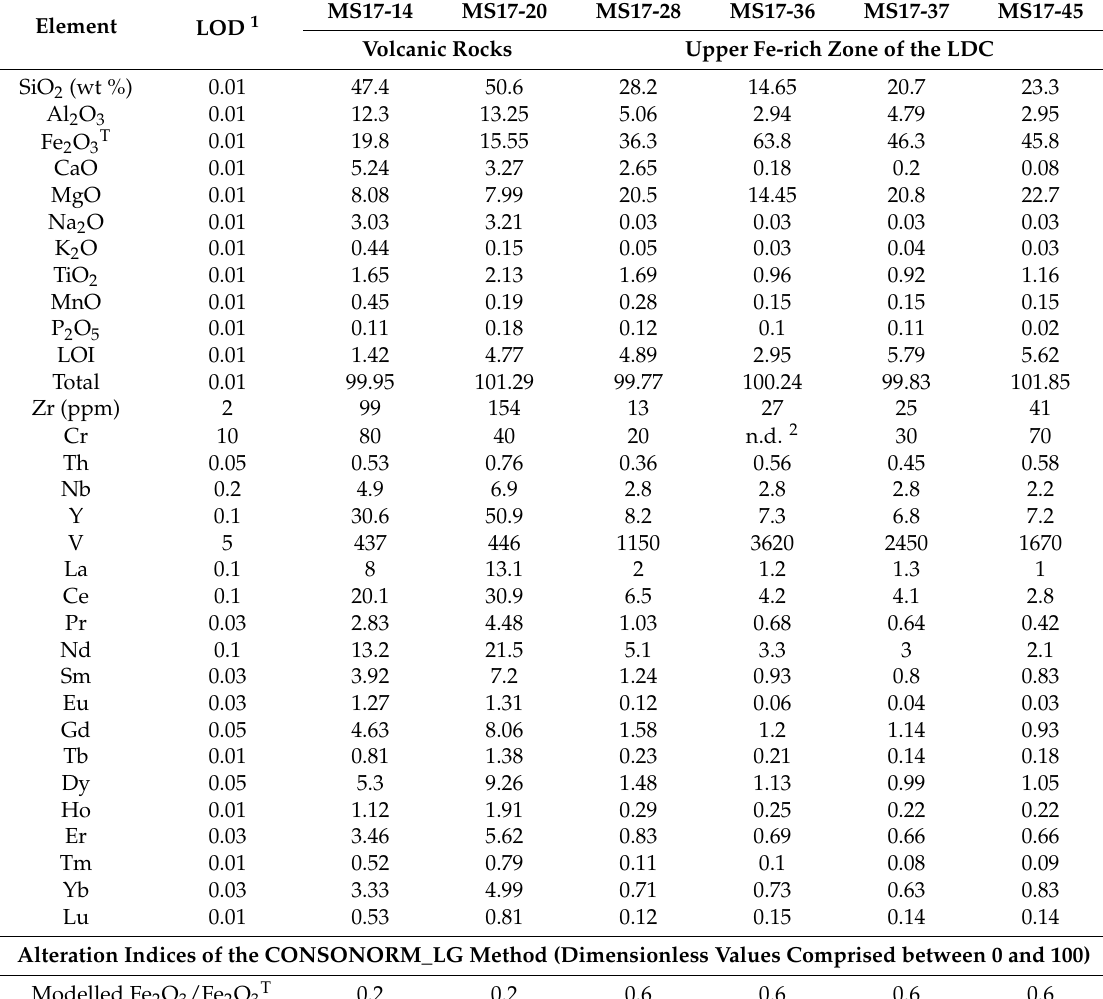
Table 1. Whole rock analyses performed on LDC and volcanic rock